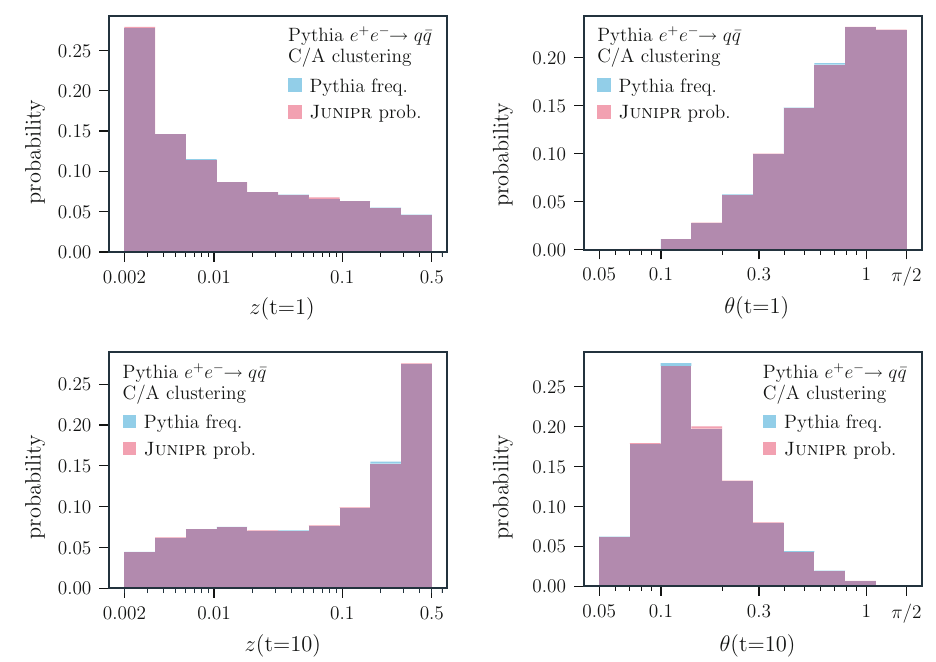
Fig. 9 Validation of P branch , the four-dimensional probability distri- bution over 1 → 2 branchings. Comparison is made between actual outcomes in the validation set of Pythia jets and Junipr ’s probabilis- tic predictions for these jets. Results are shown for energy fraction z